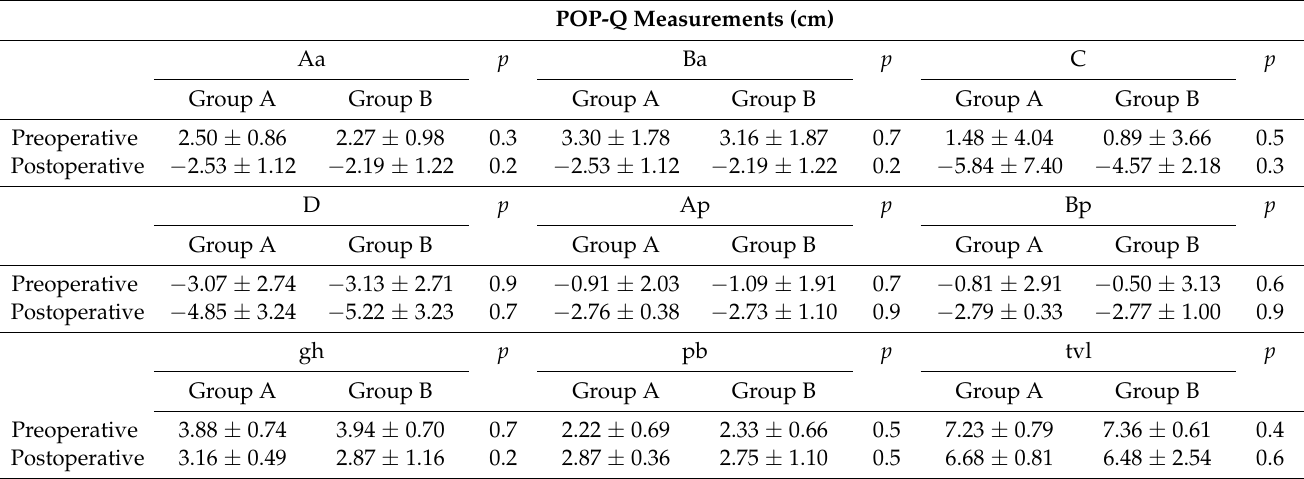
Table 2. POP-Q examination at baseline and postoperative